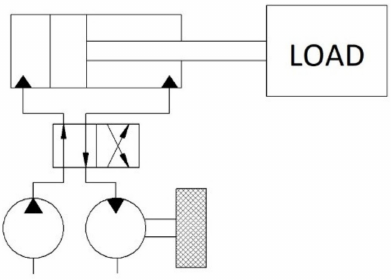
Figure 8. Flywheel (FW) application.